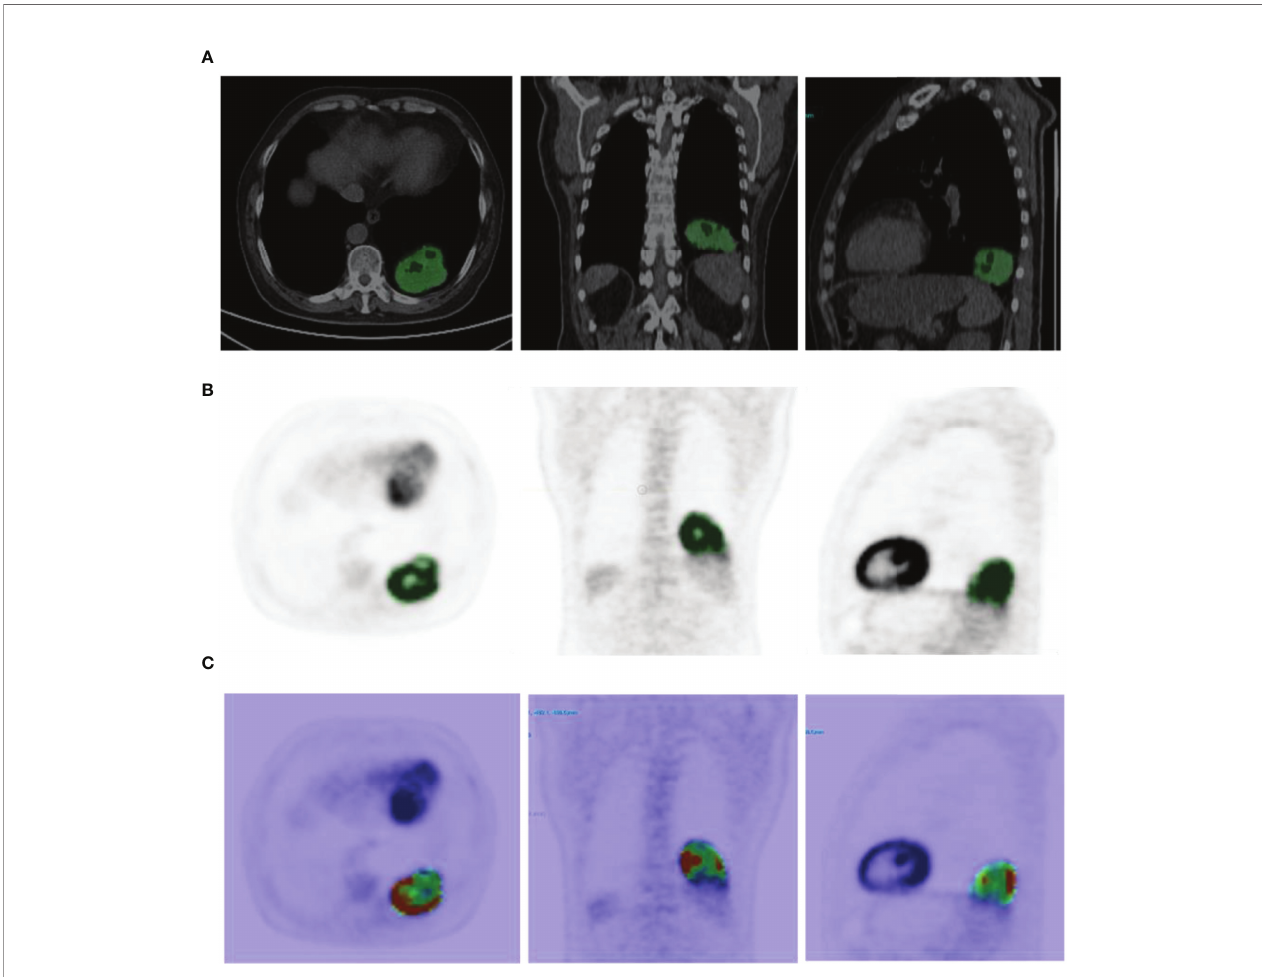
FIGURE 1 | (A) Example of CT image segmentation (the green area is the VOI drawn, the same as below). (B) Example of 68 Ga-NOTA-PRGD2 PET image segmentation. (C) Example of feature map extracted (GLCM